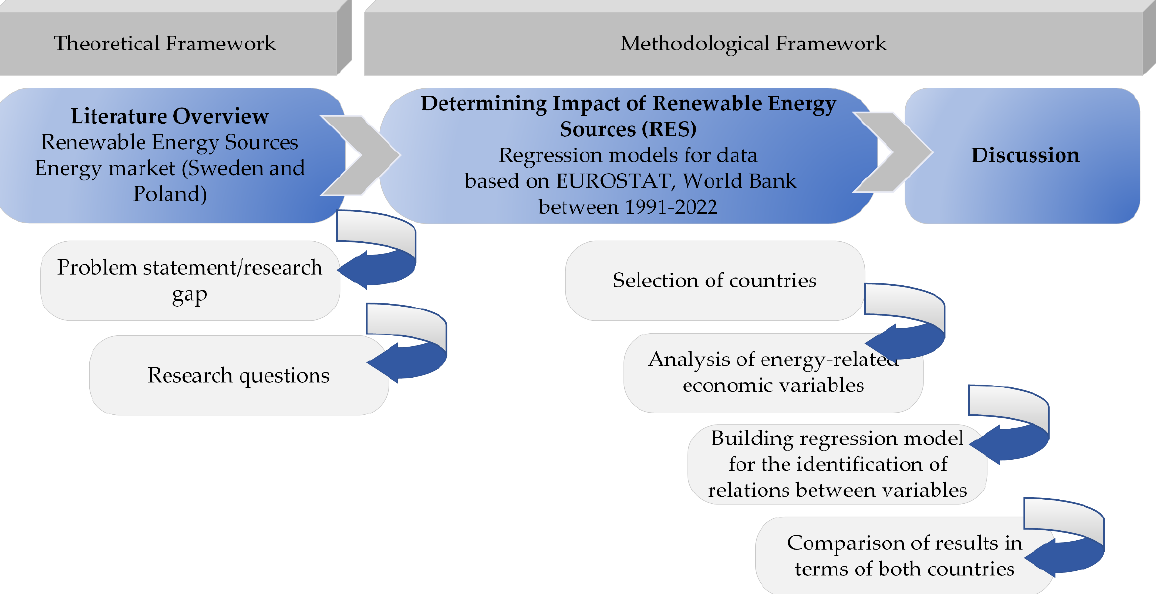
Figure 2. The proposed conceptual framework for determining the impact of RES on the economic Figure growth.